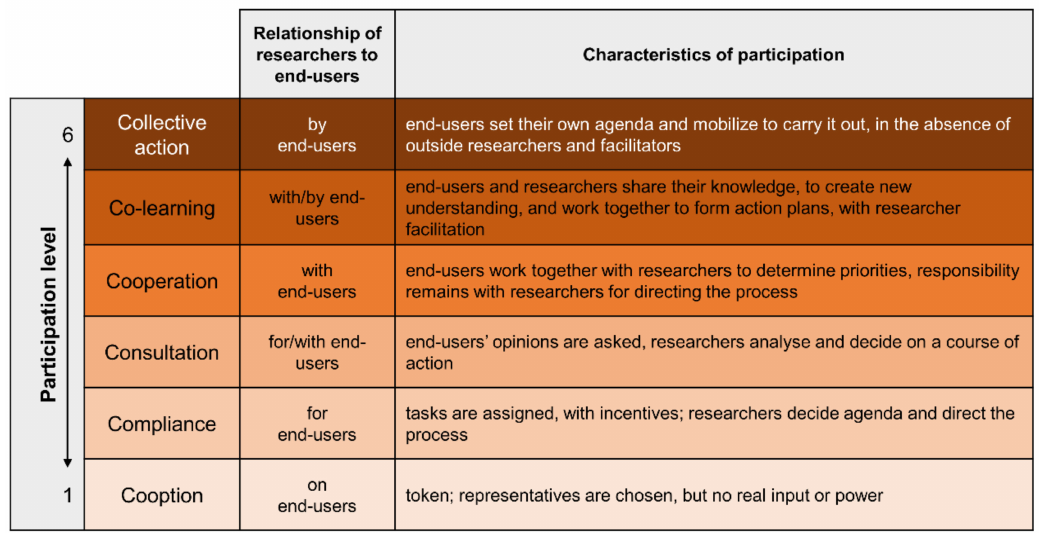
Figure 1. Participation levels, relationship of researchers to end-users, and characteristics of participation adapted from Cornwall (1996, p.